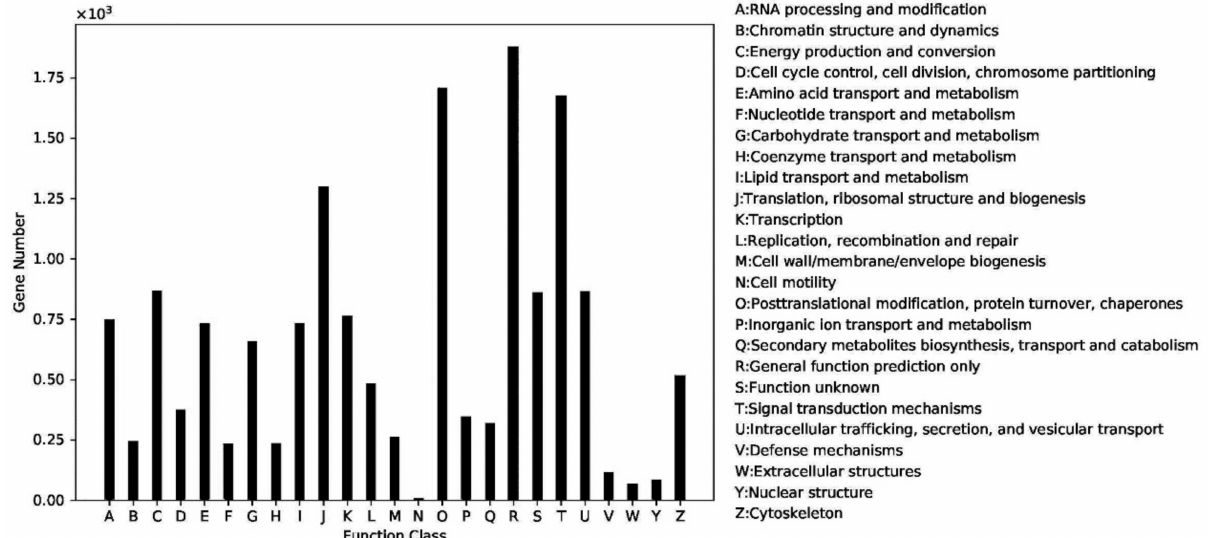
Figure 5. Gene function classification based on the KOG annotation for the predicted transcripts.